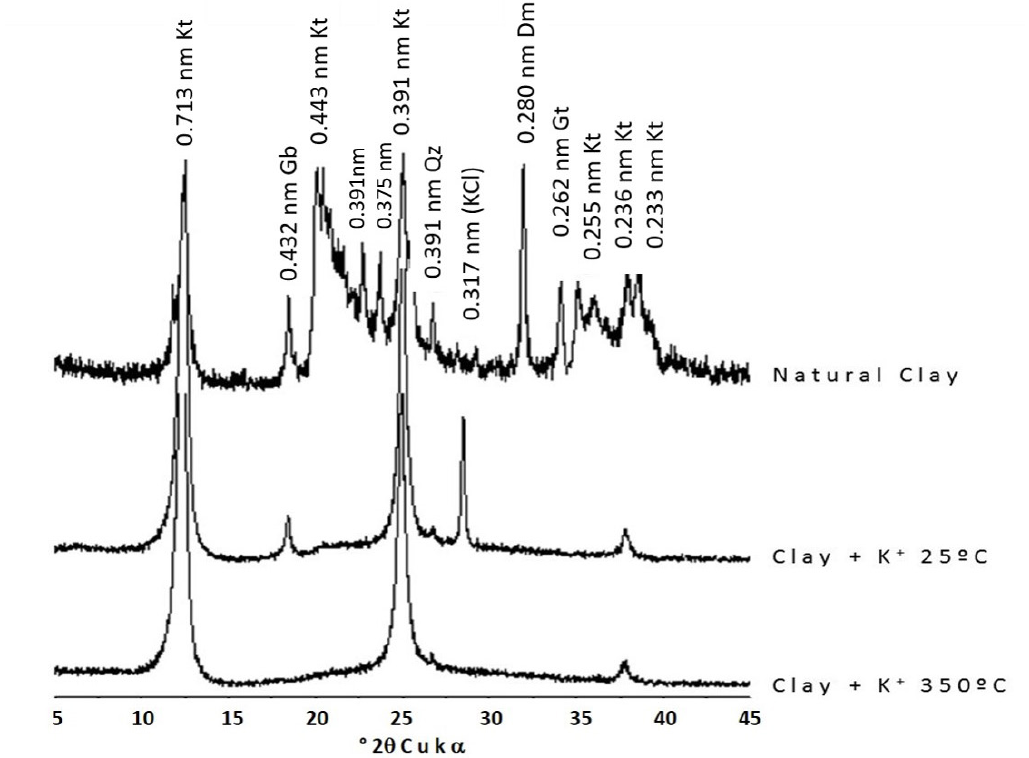
Figure 1 - Diffractogram of the natural clay fraction of the layer of 0-20